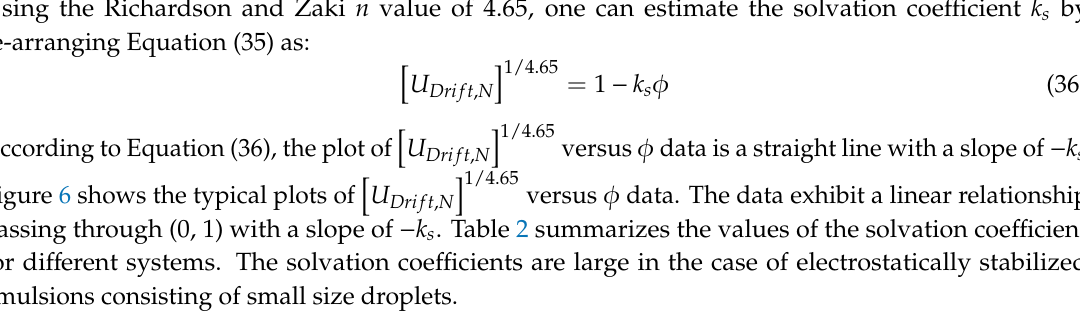
Table 2. Summary of solvation coe ffi cients for di ff erent dispersed systems. Set